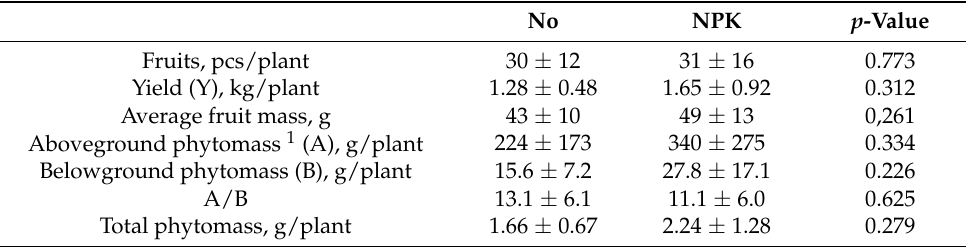
Table 7. Production characteristics of tomato plants grown under different fertilization on Phaeozem in the open field in the south of West Siberia (mean ± standard